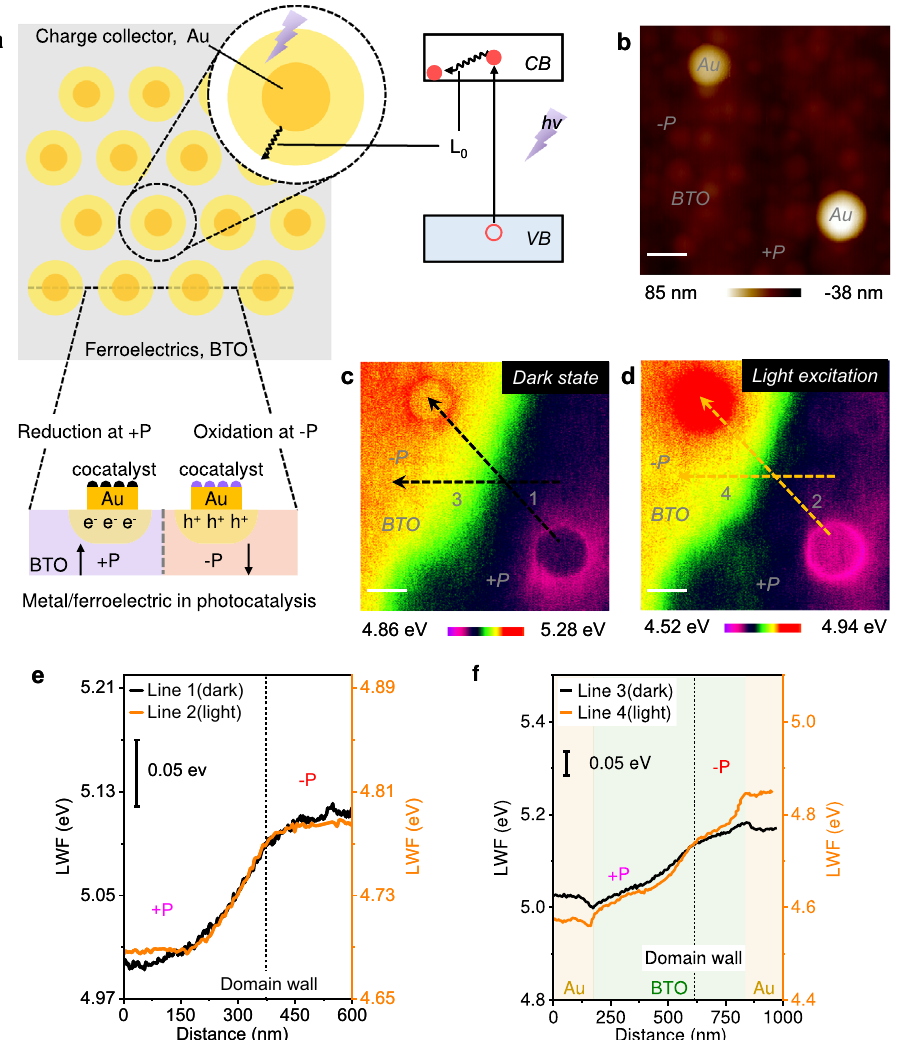
Fig. 1 Charge separation at meta/ferroelectric interface. a Schematic diagram of proposed metal/ferroelectric photocatalyst. b AFM topography of Au particles on a BaTiO 3 single crystal. Scale bar, 200 nm. c LWF of Au/BTO in the dark. Scale bar, 200 nm. d LWF of Au/BTO under 355 nm UV light (0.5 mW/cm 2 ). Scale bar, 200 nm. e Line 1 (dark) and 2 (UV light) pro fi le images were taken across two antiparallel ferroelectric domains of BTO. f Line 3 (dark) and 4 (UV light) pro fi le images were taken across two antiparallel ferroelectric domains of